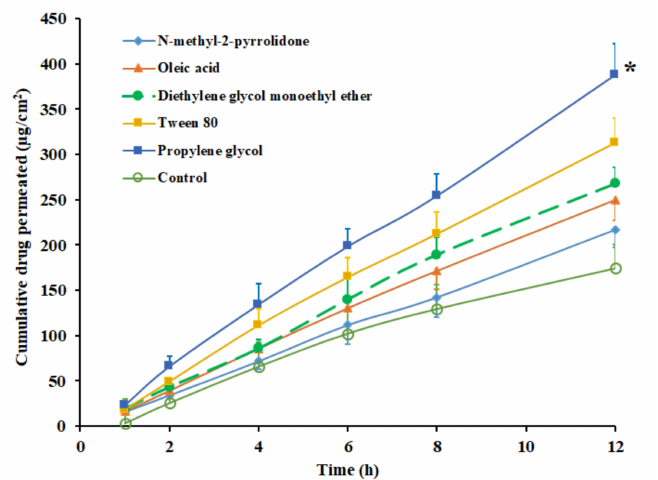
Figure 3. Amount of drug permeated across the rat skin membrane at di ff erent time intervals from Duro-Tak 87-2516 pioglitazone (2% w / w ) patch with various skin permeation enhancers. All values are mean ± SD ( n = 6). The profile of DIA patch with propylene glycol is statistically (*) di ff erent ( p < 0.05) when compared to other enhancers